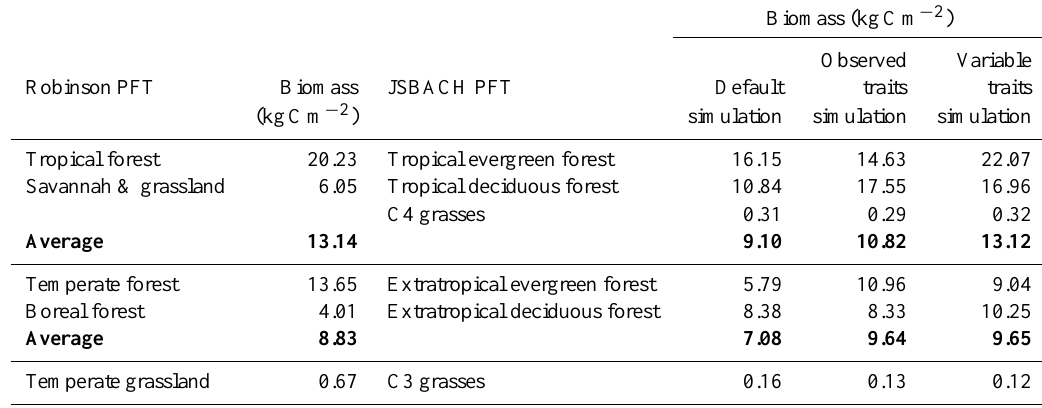
Table 4. Biomass estimates from Robinson (2007) compared to simulated biomass of the three